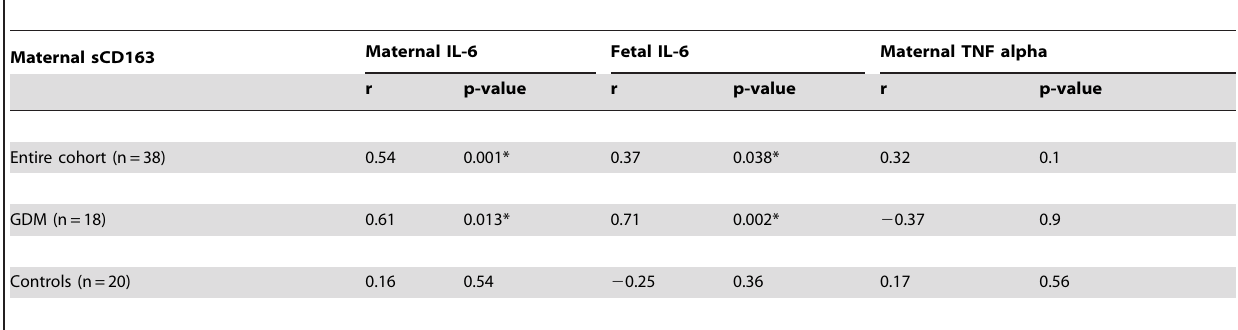
Table 2. Correlation Analyses of maternal sCD163, maternal IL-6, maternal TNF-alpha and fetal IL-6.